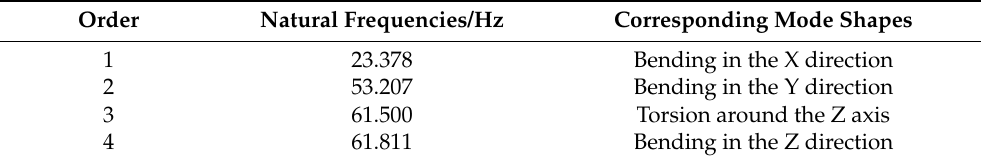
Table 2. Results of modal analysis. Order Natural